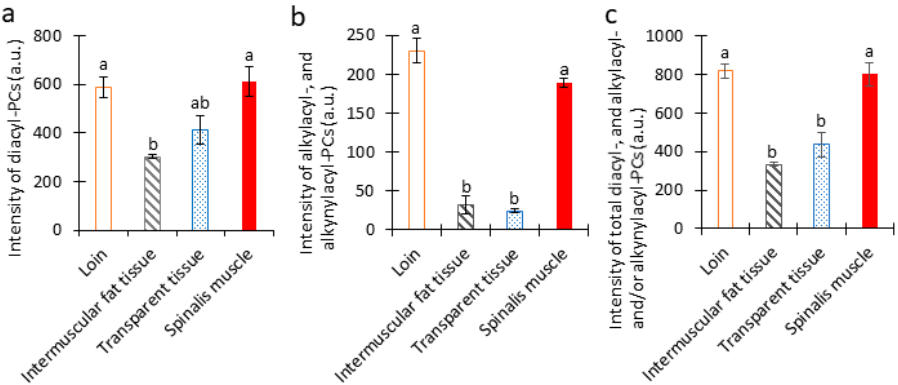
Figure 6. Amounts of total diacyl-, alkylacyl-, and alkenylacyl-phosphatidylcholine (PC) species in each tissue of a pork chop section. Intensities of ( a ) total diacyl-, ( b ) total alkylacyl- and alkenylacyl-PC species, and ( c ) total of all three PC species in longissimus thoracis et lumborum muscle (loin), intermuscular fat tissue, transparent tissue, and spinalis muscle using MALDI-MSI. The data are expressed as the mean ± standard deviation ( n = 3). Mean values with di ff erent letters indicate significant di ff erences ( p < 0.05) as determined by Dunnett’s T3 multiple comparisons